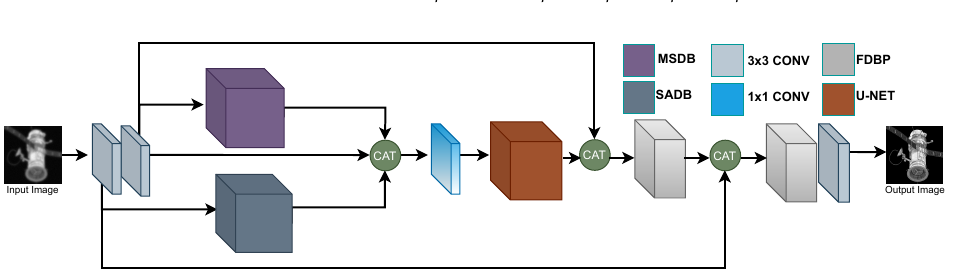
Figure 1. The proposed deep neural network model for the reconstruction of turbulence-degraded images. Here, ˆ f is the reconstructed sharp image, f p represents the result of the front-end preprocessing of the input-degraded image, S M ( · ) represents MSDB, S A ( · ) represents SADB, R ( · ) is for AU-NET, and F ( · ) is for FDBP. The proposed model first performs shallow feature extraction and denoising on the input image, and then the fused features are used